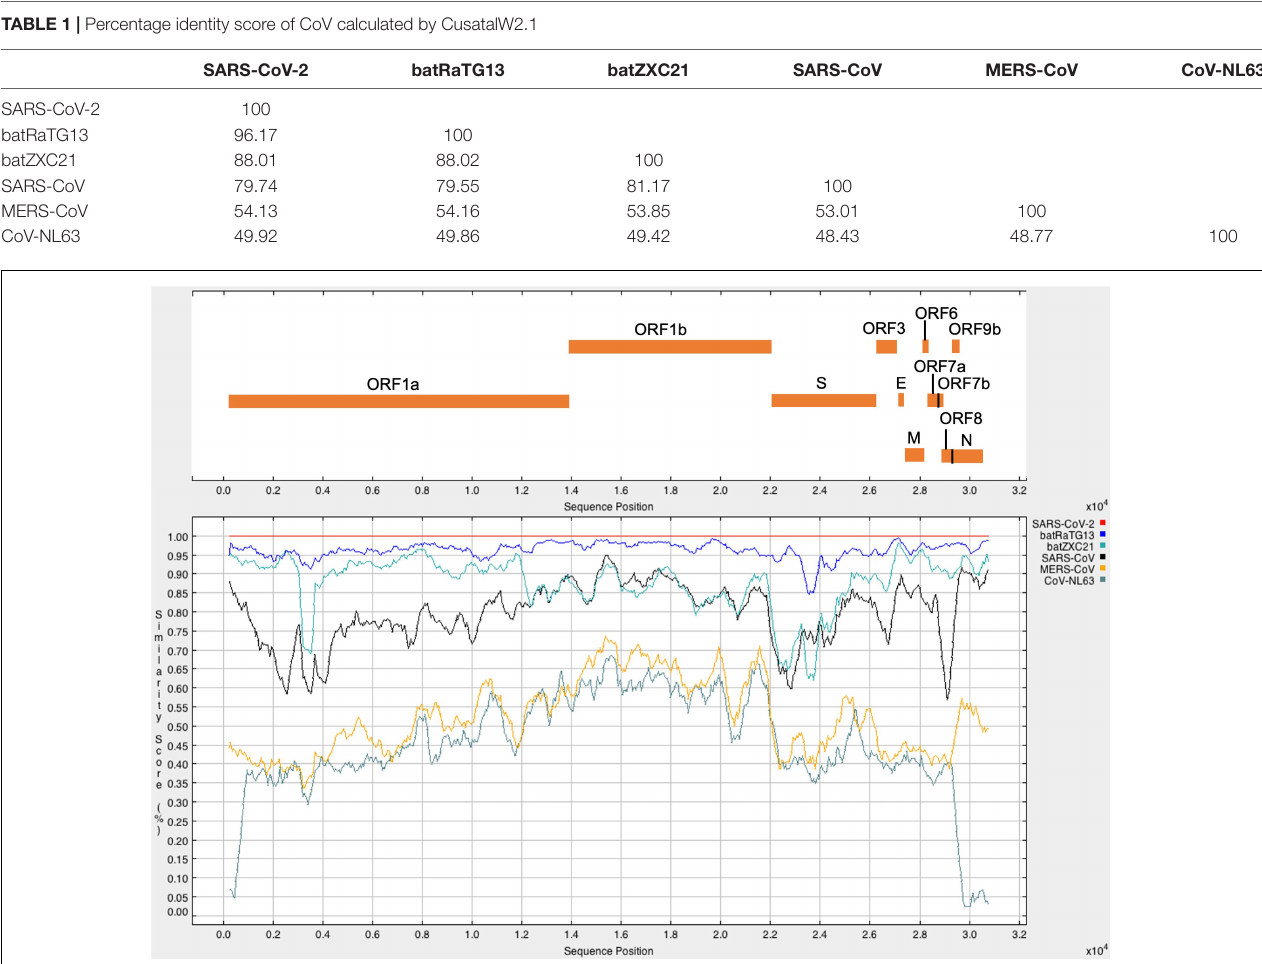
FIGURE 1 | The upper panel represents the genomic organization of SARS-CoV-2 according to positions in the aligned sequences. The lower panel represents the similarity plot of different CoV full-genome sequences with respect to SARS-CoV-2. CoV sequences were aligned using ClustalW2. Each CoV represents in a different color. A single point in the plot shows the percentage identity within a sliding window of 500 nucleotides with a step size of 50 nucleotides. The x -axis represents the nucleotide position of the aligned sequence, and the y -axis represents the similarity score between SARS-CoV-2 and other CoV sequences.